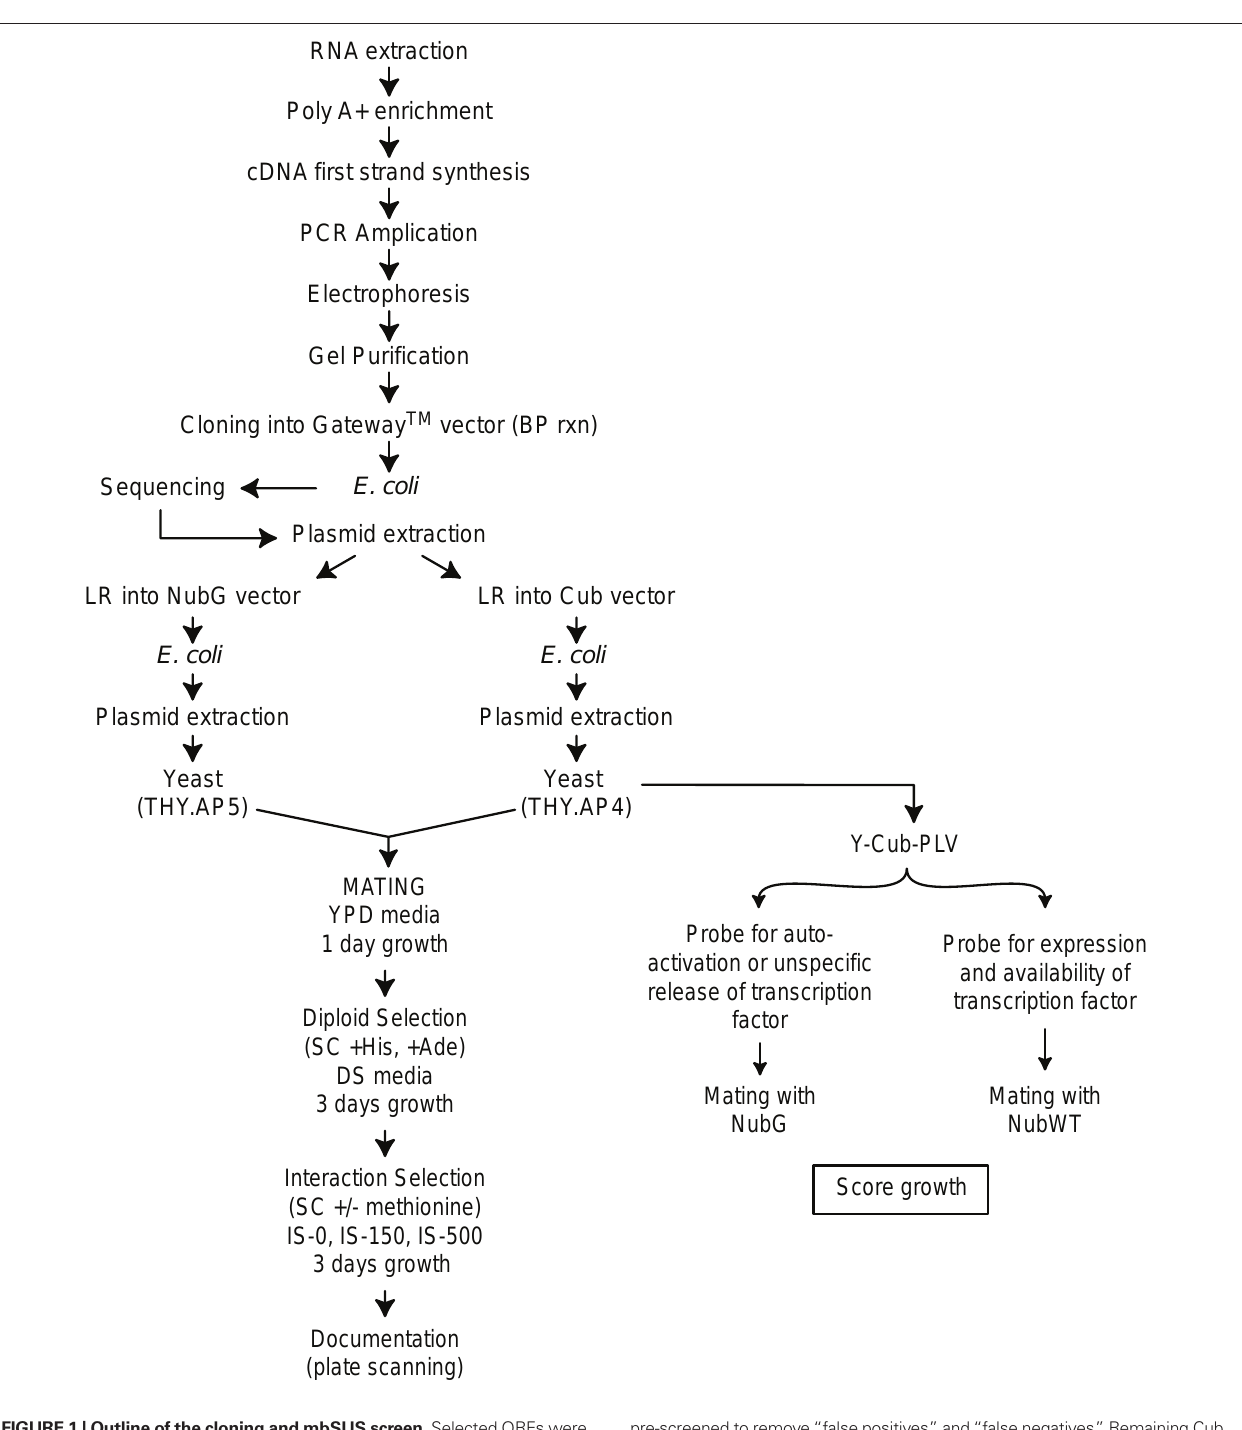
pre-screened to remove “false positives” and “false negatives.” Remaining Cub clones were mated with NubG clones that had been arrayed into two 1536-well plates. Successful mating was selected on DS media. After 3 days, diploids were replica-plated to IS media selecting for activation of the His3 and Ade2 markers and growth was